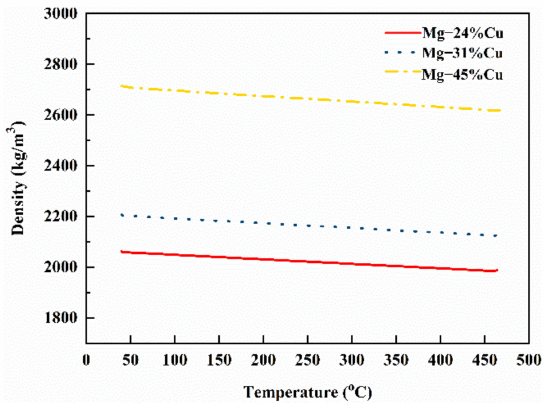
Figure 5. Density changes with temperature.